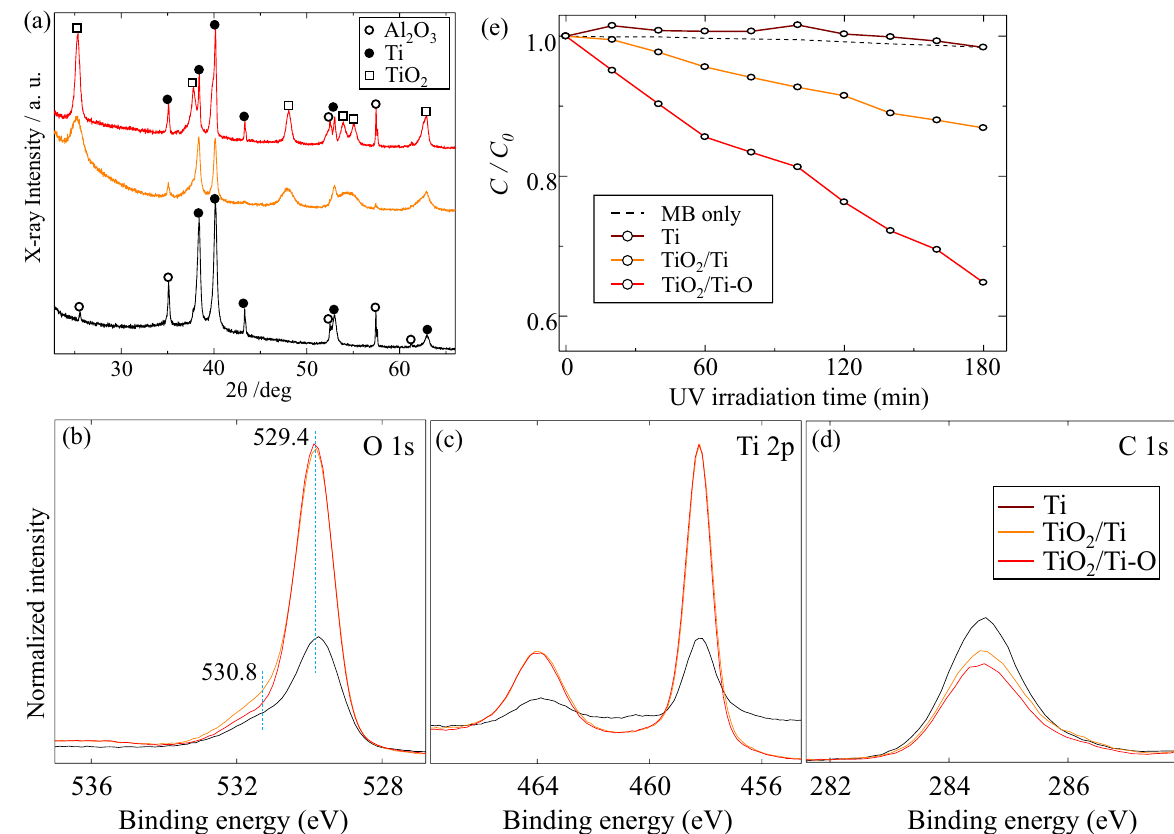
Figure 2. XRD patterns of the samples. ( a ) XRD patterns, ( b ) O 1s XPS spectra, ( c ) Ti 2p XPS spectra, ( d ) C 1s XPS spectra, and ( e ) the photocatalytic activity towards the degradation of MB